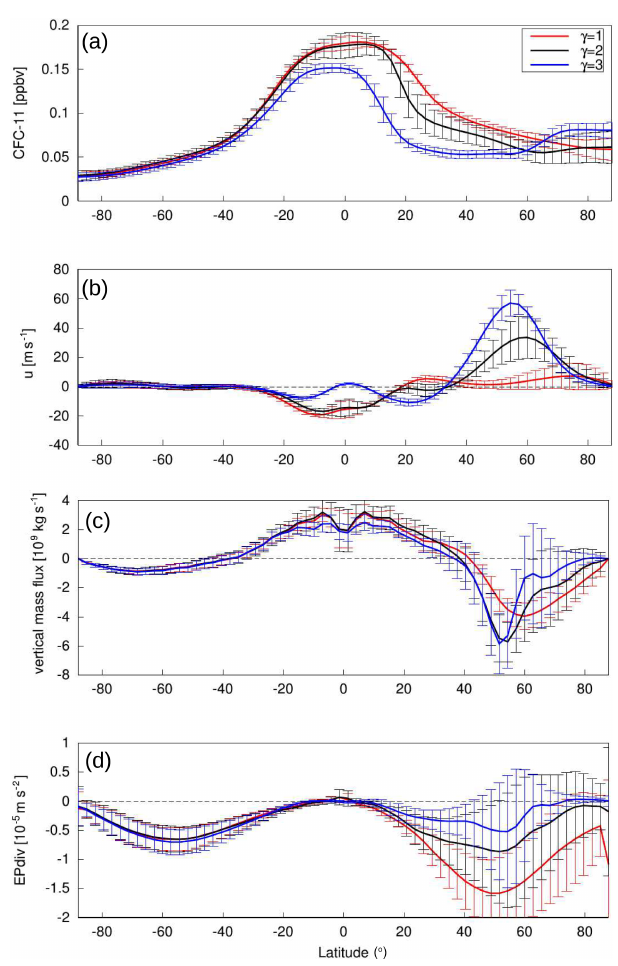
Figure 13. (a) Zonal-mean CFC-11 mixing ratios, (b) zonal-mean zonal wind, (c) mean vertical mass flux and (d) Eliassen–Palm (EP) flux divergence, all at 50hPa as function of latitude for EMIL sim- ulations with the PK setup with p Tw = 400hPa and γ = 1 (red), 2 (black) and 3Kkm − 1